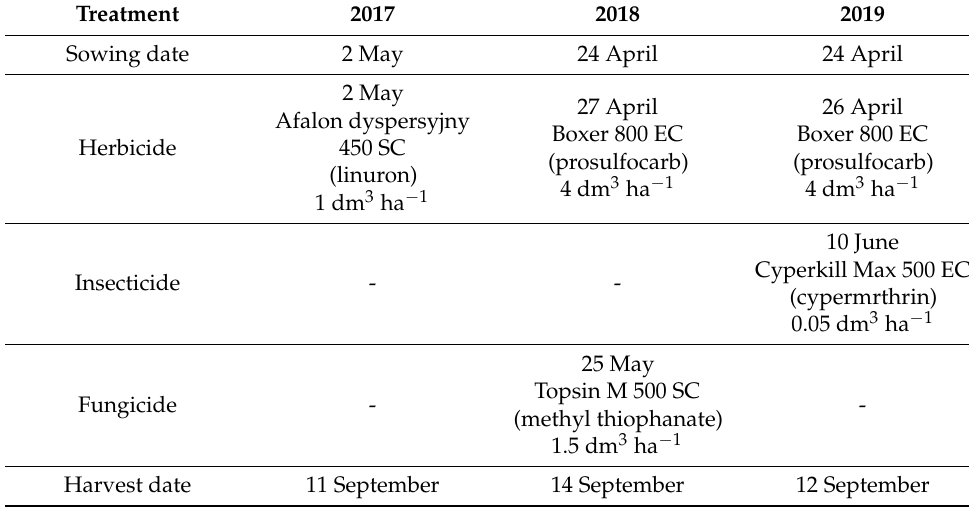
Table 1. Agrotechnical treatments carried out in the study.